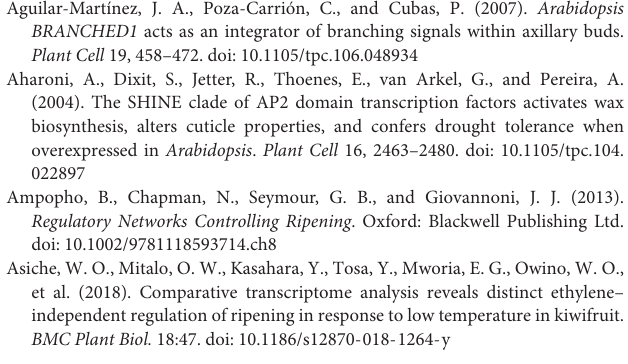
replicates. FIGURE S4 | Overview of changes in fruit chemistry during development. An illustration of the six stages of fruit development are shown at the top of the figure. Horizontal bars indicate the relative abundance of different groups of compounds during fruit development. TABLE S1 | Primers used for qRT-PCR. TABLE S2 | Change in relative abundance of chemicals at six different stages of fruit development. TABLE S3 | Transcripts exhibiting significant changes in abundance during fruit development. TABLE S4 | Significantly enriched gene ontology terms amongst transcripts assigned to six K means clusters dependent on changes in abundance during fruit development. TABLE S5 | Transcripts encoding transcription factors exhibiting significant differences in abundance during fruit development. TABLE S6 | Transcripts encoding proteins associated with hormone metabolism and signaling exhibiting significant differences in abundance during fruit development. Transcripts associated with metabolisms and signaling of cytokinin (A) , auxin (B) , gibberellin (C) , ethylene (D) , abscisic acid (E) , brassinosteroid (F) , jasmonate (G) , and salicylate (H) are